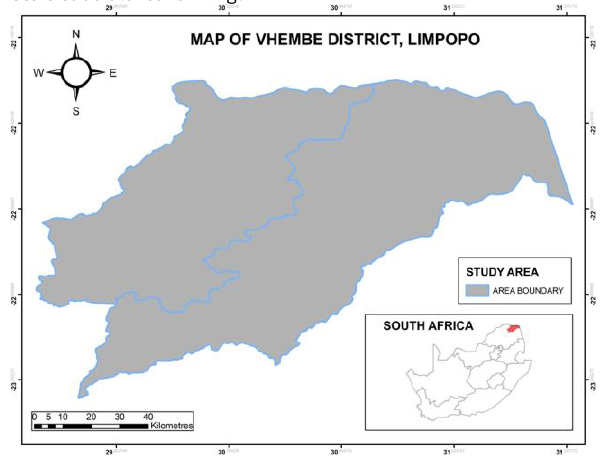
Figure 1. Study Area: Vhembe District, South Africa; Source: (Vhembe District Municipality, 2016).